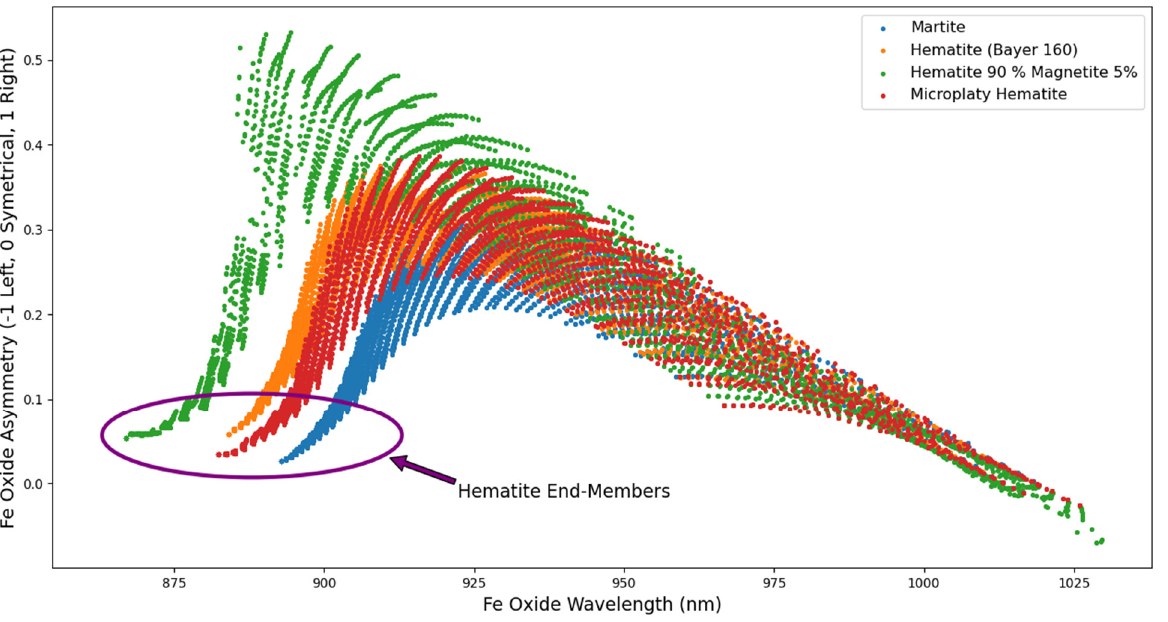
Figure 9. The Fe Oxide Wavelength versus the Asymmetry for the 4 different hematite endmembers mixed with the same randomly selected ochreous and vitreous endmember. Circled in purple are those values for which the hematite mixing ratio terminates at 100%. It is apparent that hematite endmembers can be extracted by taking a representative selection across the terminating line circled.